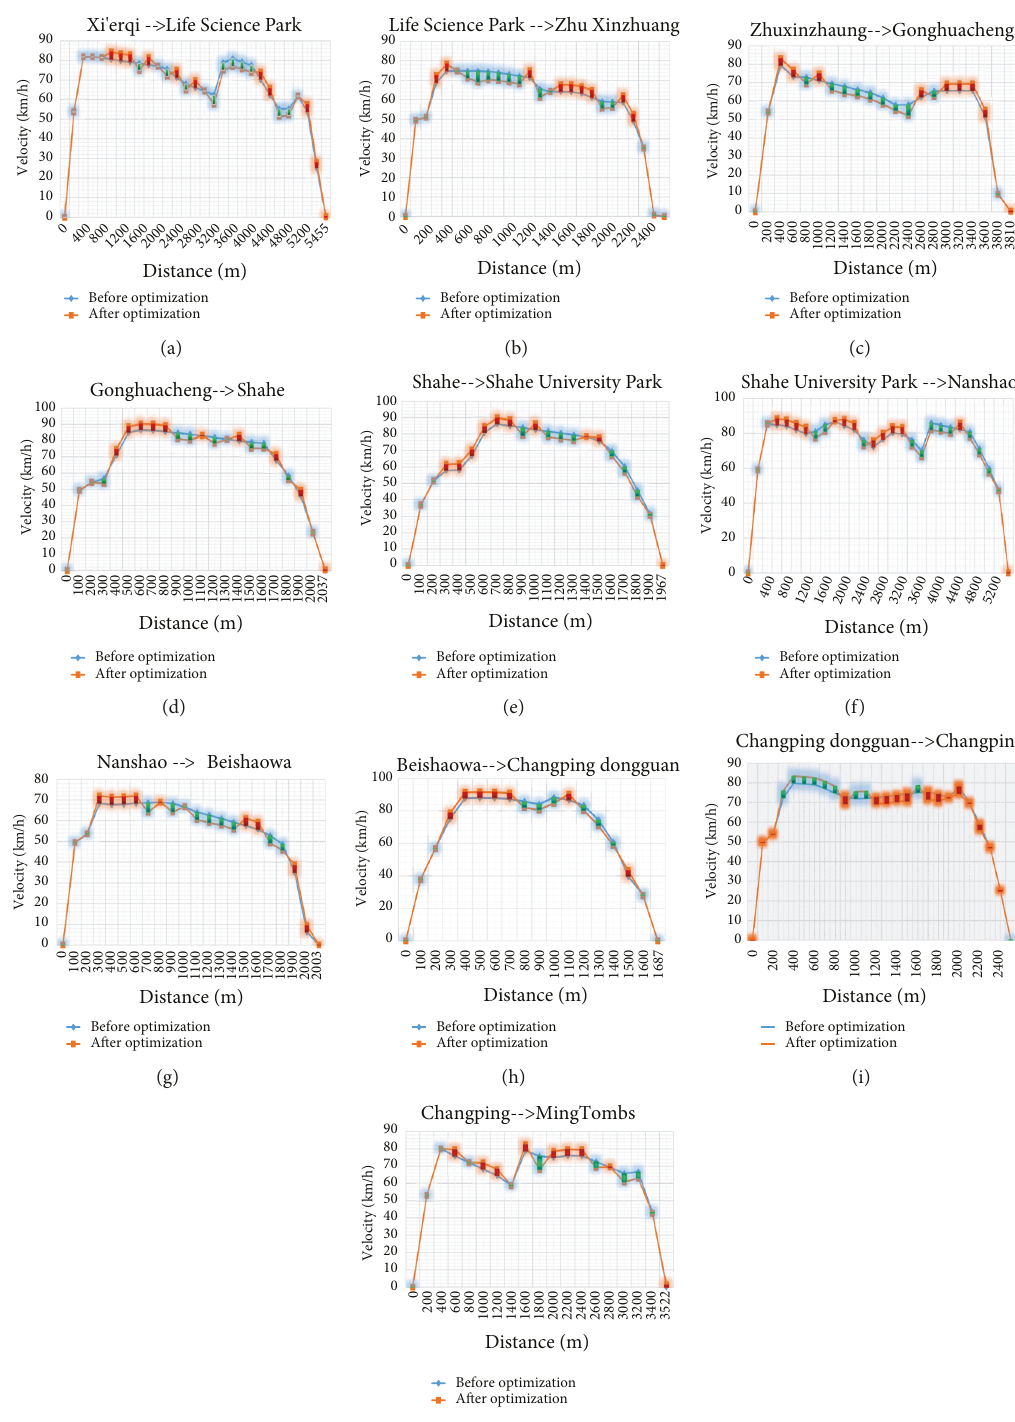
Figure 17: The obtained profiles in different sections. Section (a)–(j) are listed in Table 6.